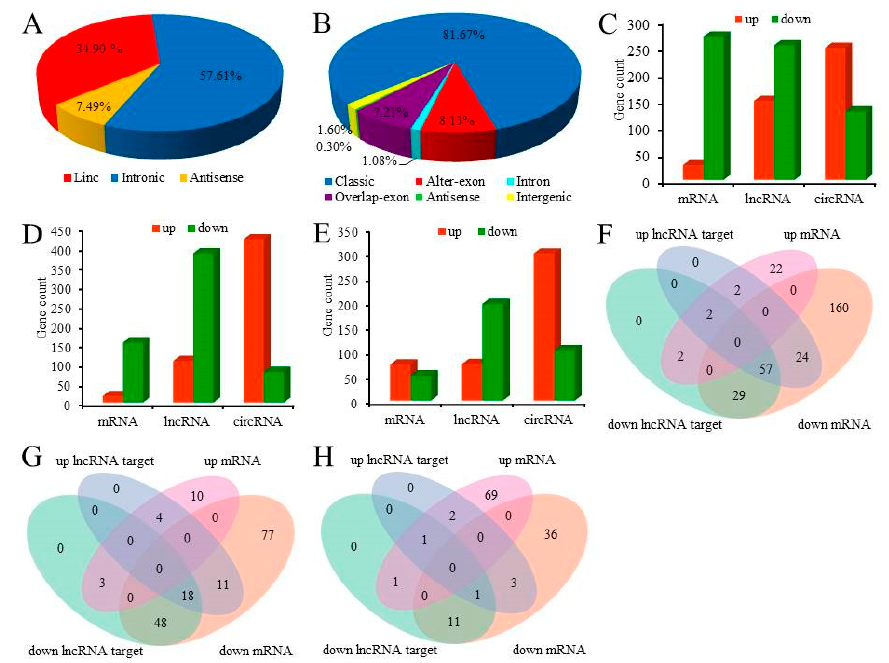
Figure 1. Gene expression characterization. ( A ) The type and proportion of lncRNAs. ( B ) The percentage of six types of circRNAs. ( C ) Histogram representing the numbers of upregulated and downregulated mRNAs and ncRNAs in sheep uteri between the short photoperiod (SP) and long photoperiod (LP) groups. ( D ) Histogram representing the numbers of upregulated and downregulated mRNAs and ncRNAs in sheep uteri between the SP and short transfer to long photoperiod (SLP) groups. ( E ) Histogram representing the numbers of upregulated and downregulated mRNAs and ncRNAs in sheep uteri between the LP and SLP groups. ( F ) Venn diagram representing the overlapping numbers of upregulated lncRNA-targeted mRNAs, downregulated lncRNA-targeted mRNAs, upregulated mRNAs, and downregulated mRNAs between the SP and LP groups. ( G ) Venn diagram representing the overlapping numbers of upregulated lncRNA-targeted mRNAs, downregulated lncRNA-targeted mRNAs, upregulated mRNAs, and downregulated mRNAs between the SP and SLP groups. (H) Venn diagram representing the overlapping numbers of upregulated lncRNA-targeted mRNAs, downregulated lncRNA-targeted mRNAs, upregulated mRNAs, and downregulated mRNAs between the LP and SLP